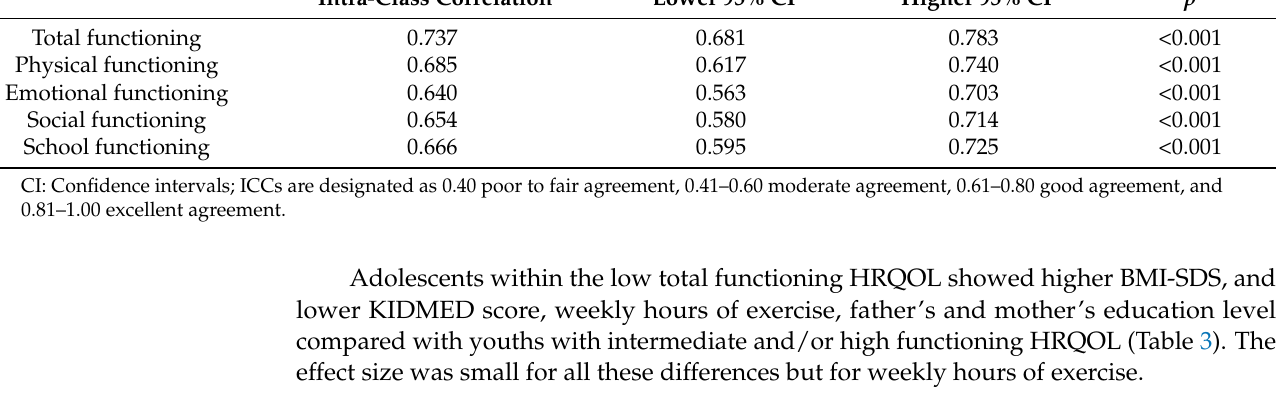
Table 3. Demographic, anthropometric features and lifestyle habits, and parental characteristics among adolescents stratified by total HRQOL